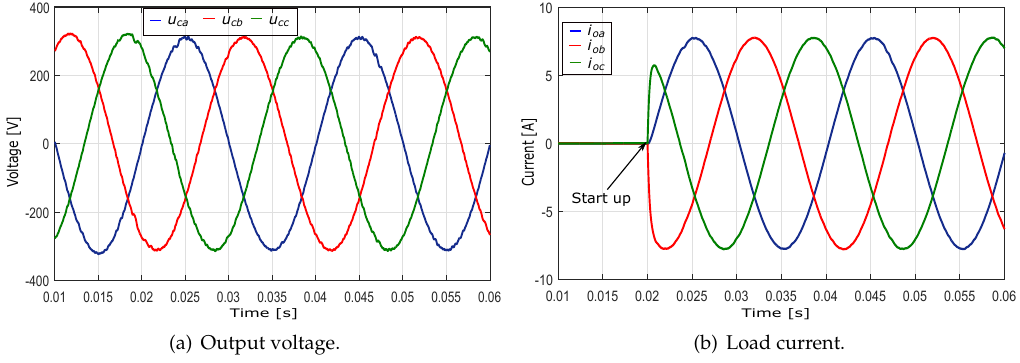
Figure 13. Output voltage and current with the resistive–inductive load step at t = 0.02 s.